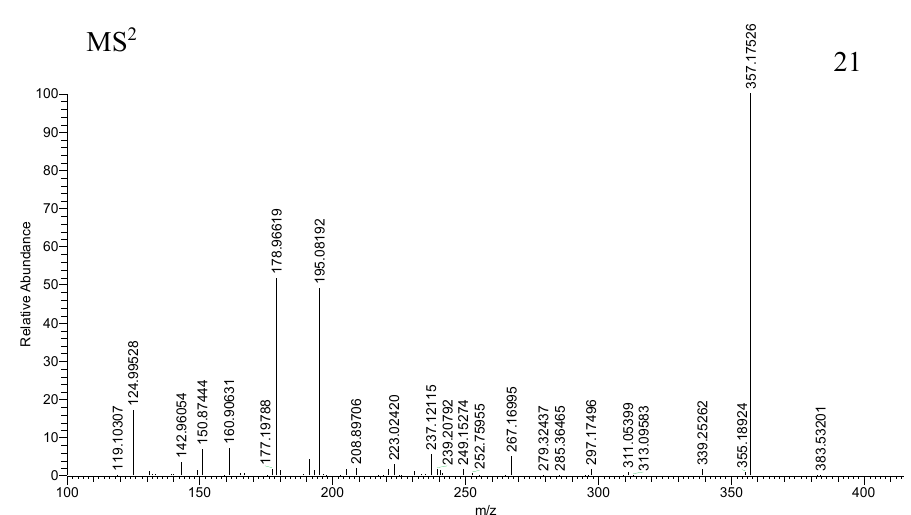
Figure 5. Spectra of ion fragments in MS n analysis of 6 ′ - O - β - D -glucosyl swertiamarin ( 8 ), swertiamarin ( 14 ), sweroside ( 21 ) in negative ion mode.